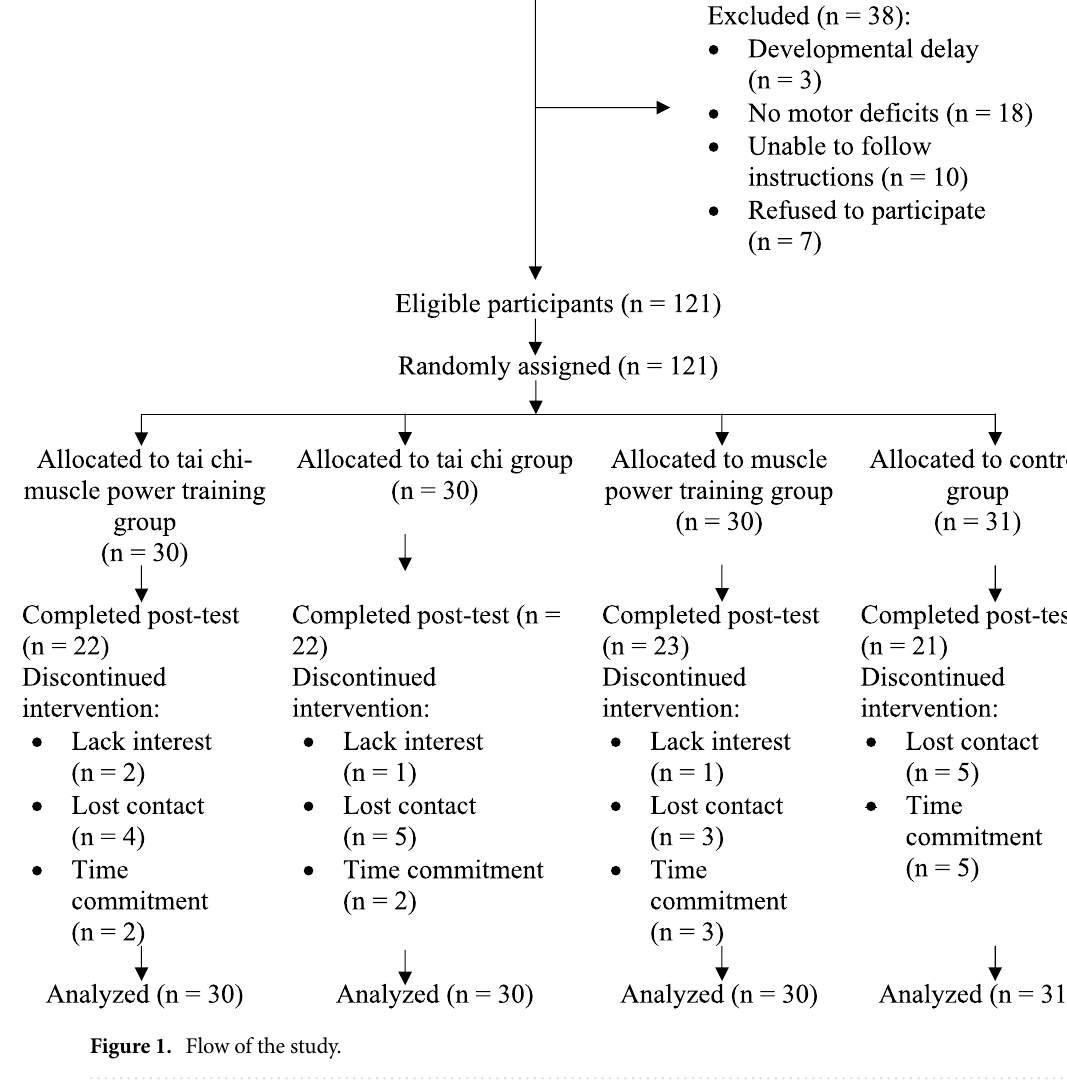
Figure 1. Flow of the study.